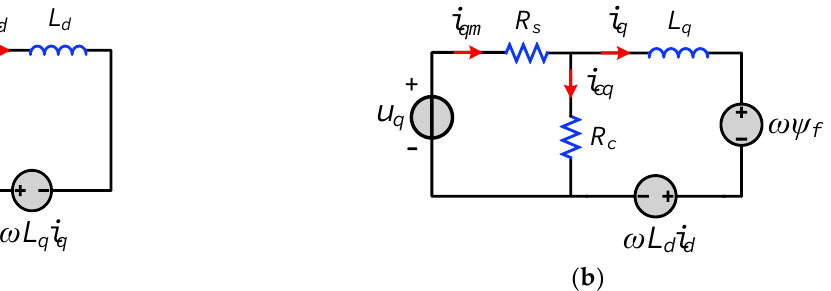
Figure 4. PMSM equivalent circuit considering the ferromagnetic loss: ( a ) d-axis circuit; ( b ) q-axis circuit.